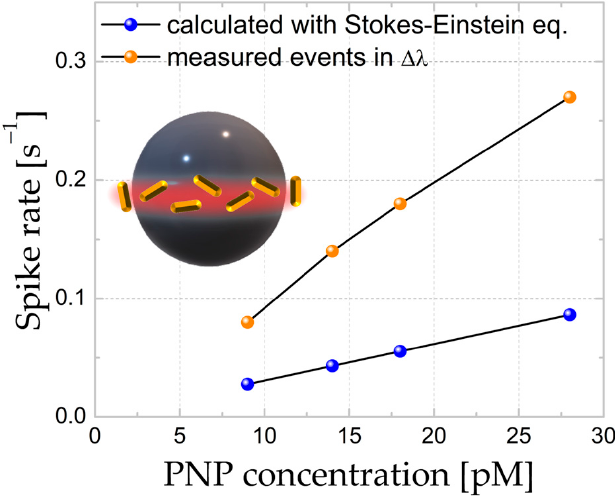
Figure 5. Both spike rates experimentally determined and calculated according to the Stoke–Einstein equation and Fick’s law. Experiments correspond to increasingly higher concentrations of Au-NR@HS-Si(OH) n in pH = 7 aqueous solutions. Exposed area for PNP interaction is 1200 μ m 2 , assuming an equatorial section of 5 μ m and a radius of 40 μ m.